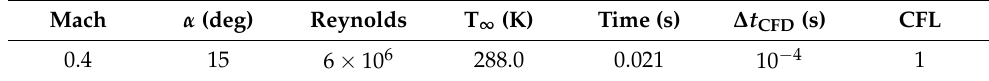
Table 4. Formation flight simulation